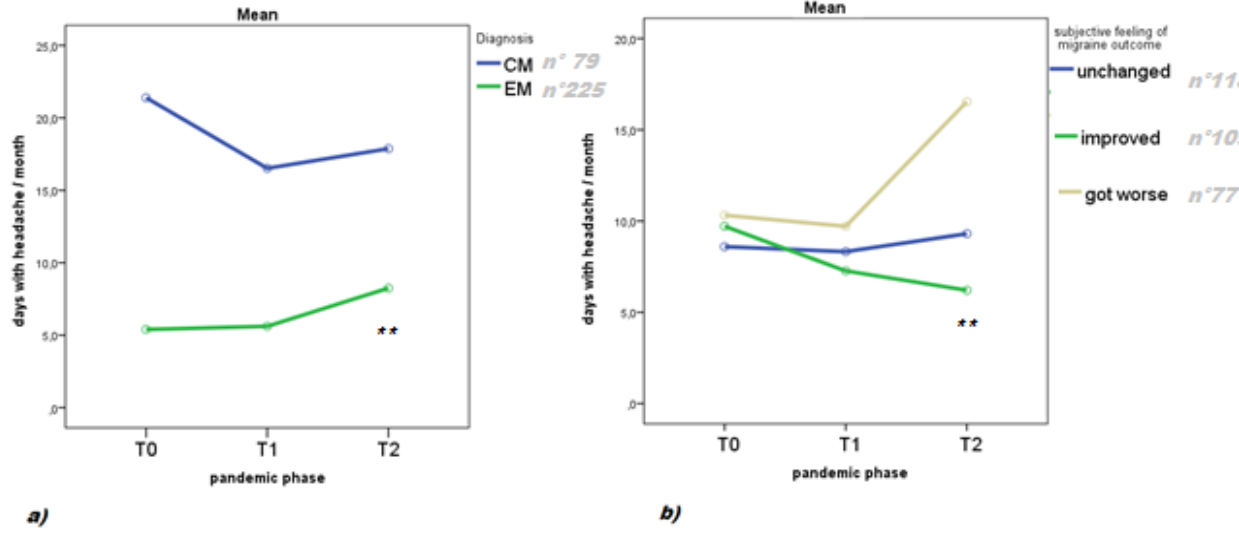
Figure 2. Headache frequency before pandemic (T0), during first pandemic phase (T1), and during second pandemic phase (T2). Results of repeated measures ANOVA with: ( a ) migraine diagnosis at baseline (episodic migraine, EM; chronic migraine, CM) as factor F: 24.49 p < 0.0001; degree of freedom 2; degree of error: 301; ** T0 vs. T2, T1 vs. T2 p < 0.01; ( b ) subjective judgment of outcome as factor: F 22.61 p <0.0001; degree of freedom 4; degree of error 602; ** T0 vs. T2 and T1 vs. T2 p <